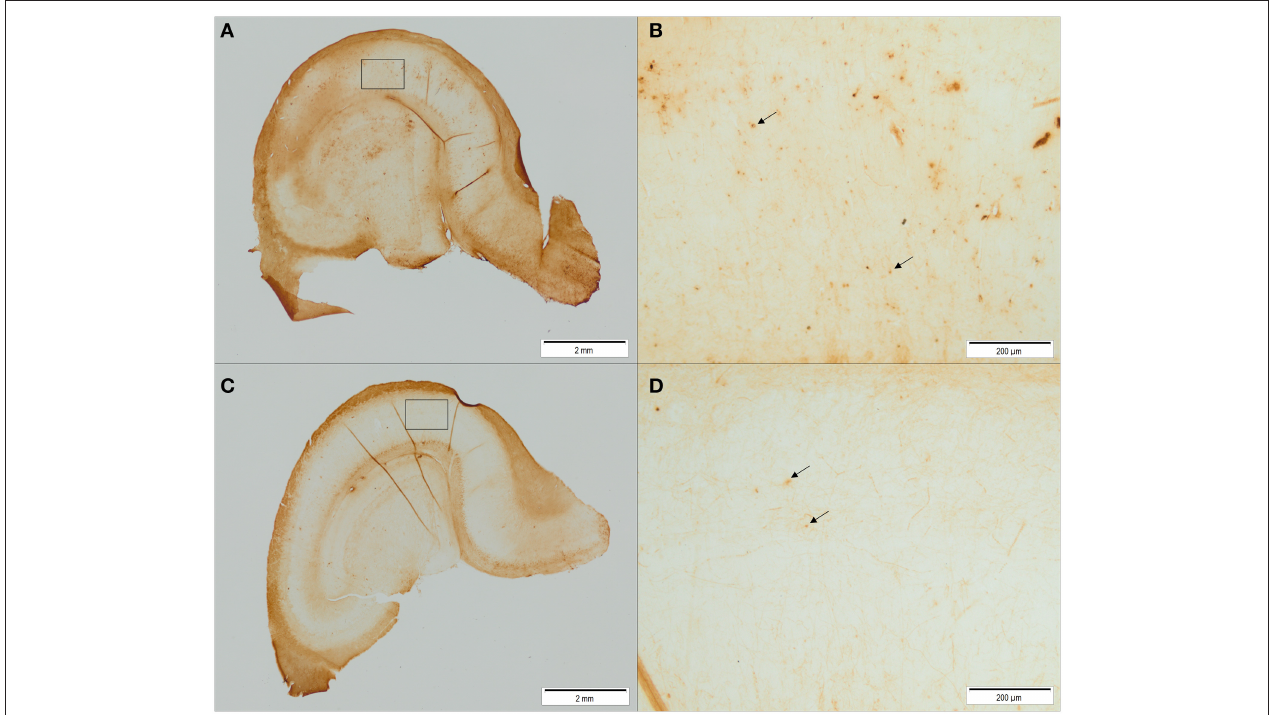
FIGURE 7 | Representative pictures of iron stained hippocampal sections of control animals (A,B) and ID animals (C,D) at 12 weeks of age. Sections of ID animals contained significantly fewer iron-containing cells in CA1 ( p = 0.02 ) and dentate gyrus ( p = 0.002 ) regions than sections of control animals ( A,C : scale bar = 2mm, magnification 1.26x; B,D : scale bar = 200 µ m, magnification 12.6x).